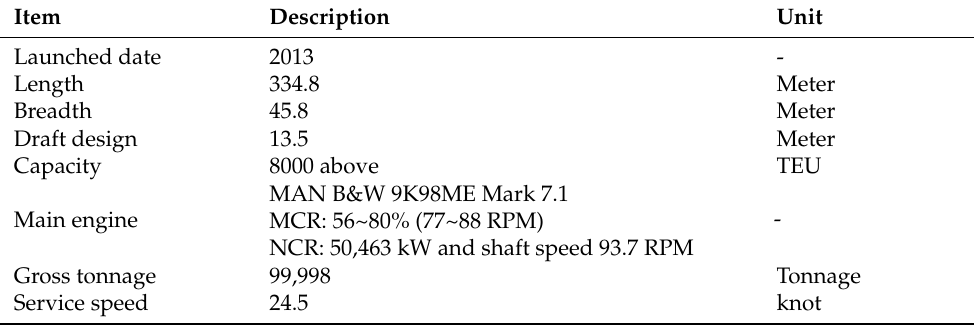
Table 2. Technical specifications of the container